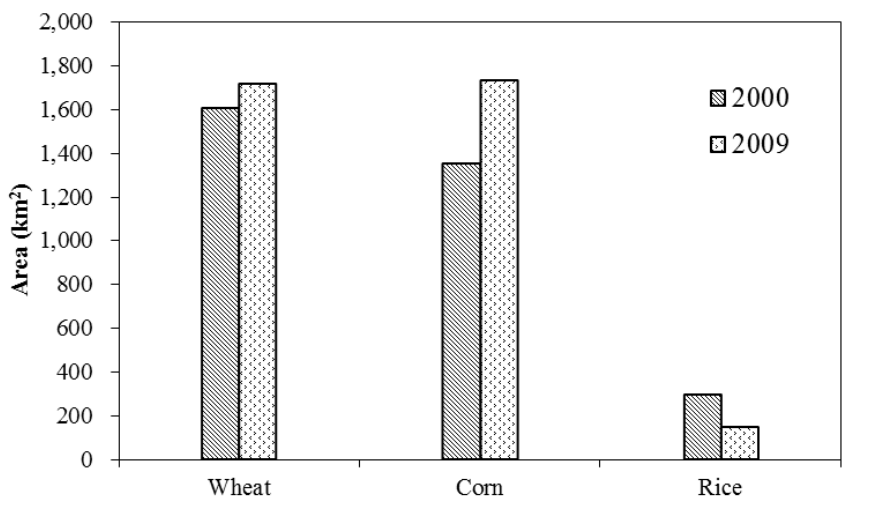
Figure 5. Changes of wheat, corn, and rice planting areas between 2000 and 2009.